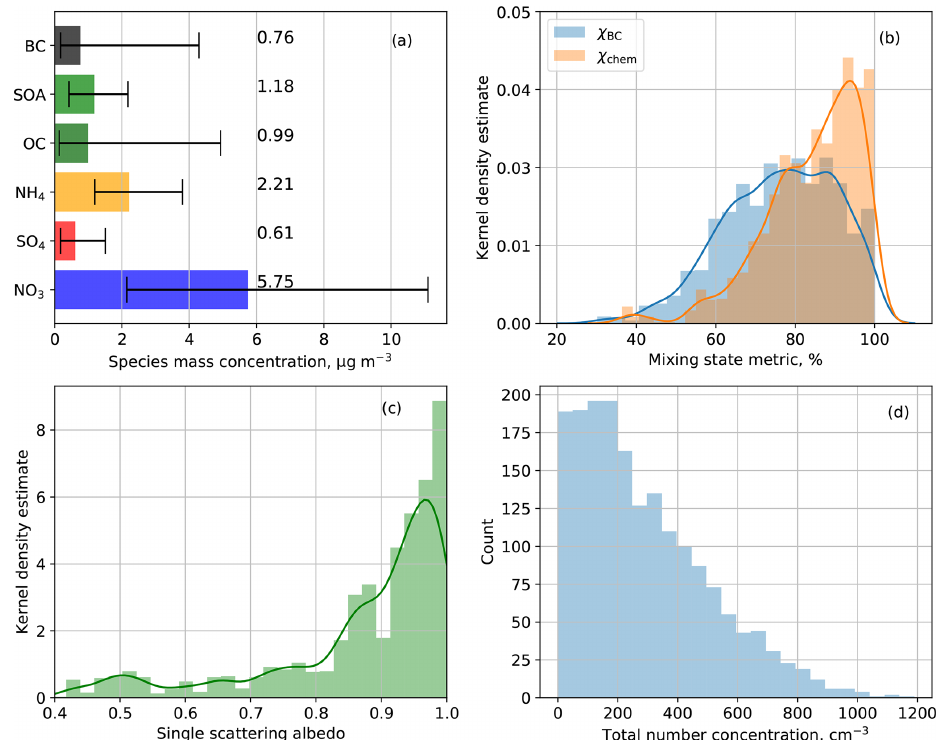
Figure 3. Distribution of (a) bulk species concentration, (b) mixing state metric χ BC and χ chem , (c) SSA and (d) total number concentration in the scenario library. Error bars in (a) are for ± 1 interquartile range (IQR), and numbers are the species median concentration in micrograms per cubic meter (µgm − 3